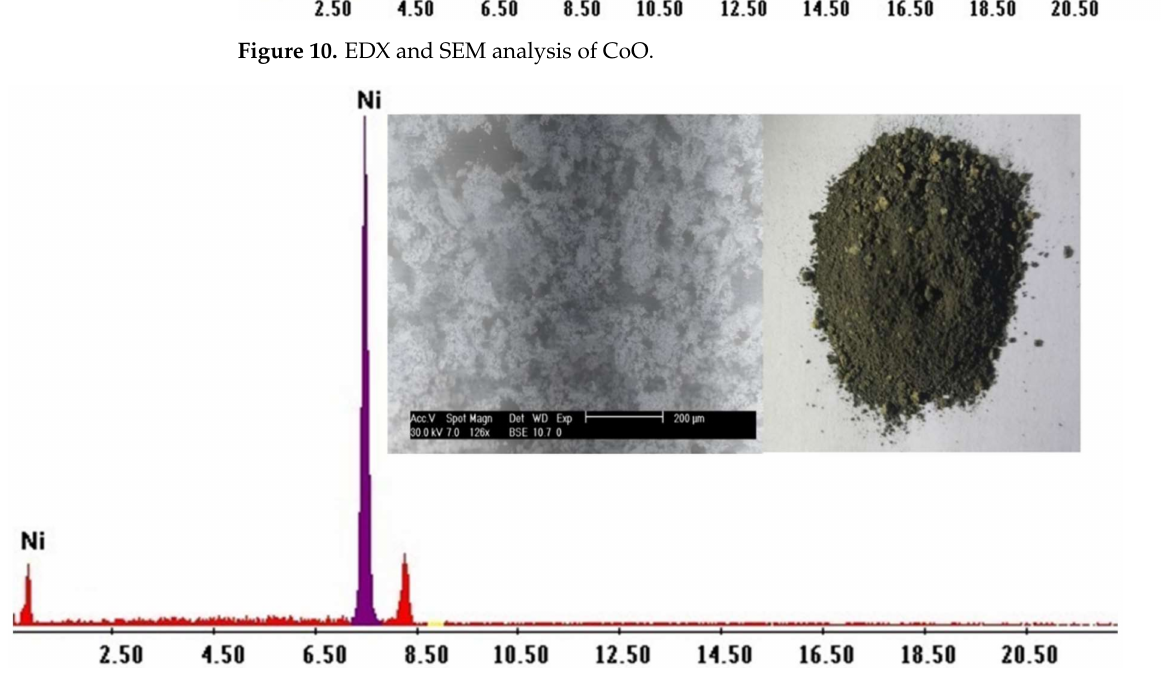
Figure 11. EDX and SEM analysis of